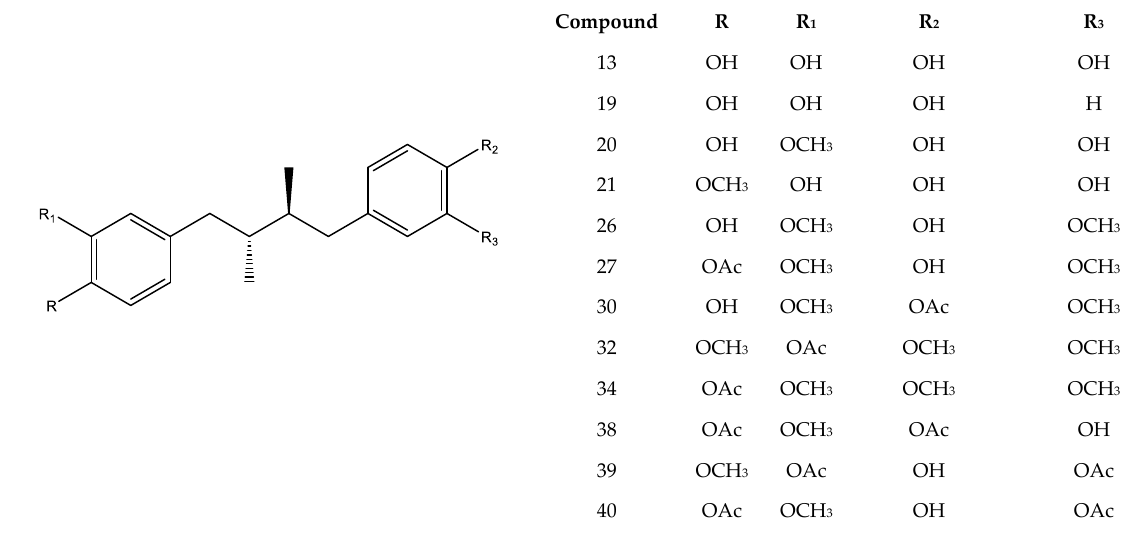
Figure 3. Main NDGA and MNDGA lignans derivatives characterized in LnRe and LdRe resins. Table 1. Ultrahigh resolution liquid chromatography orbitrap MS analysis (UHPLC-PDA-MS) orbitrap mass spectral data of LdRe and LnRe resins. T R Peak